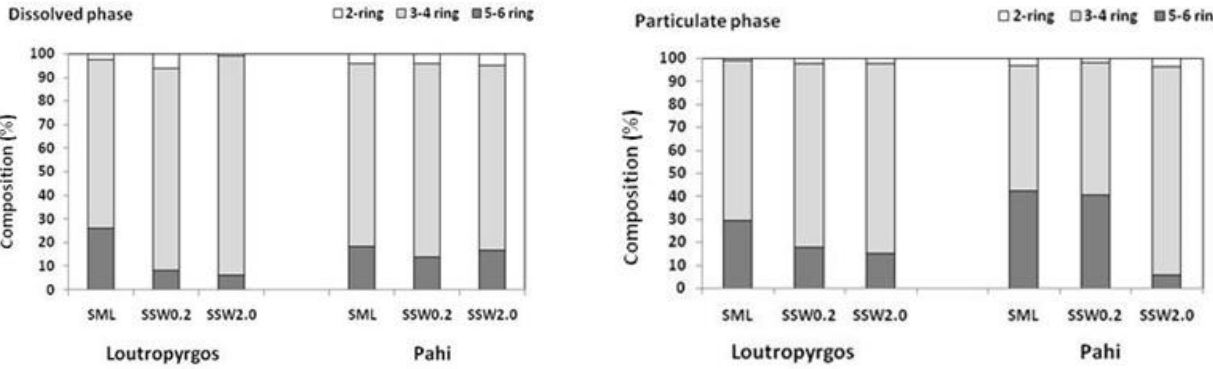
Figure 3. Composition patterns (% percentage) of mean PAHs concentrations measured in the dissolved and particulate phases at thesampling sites studied.